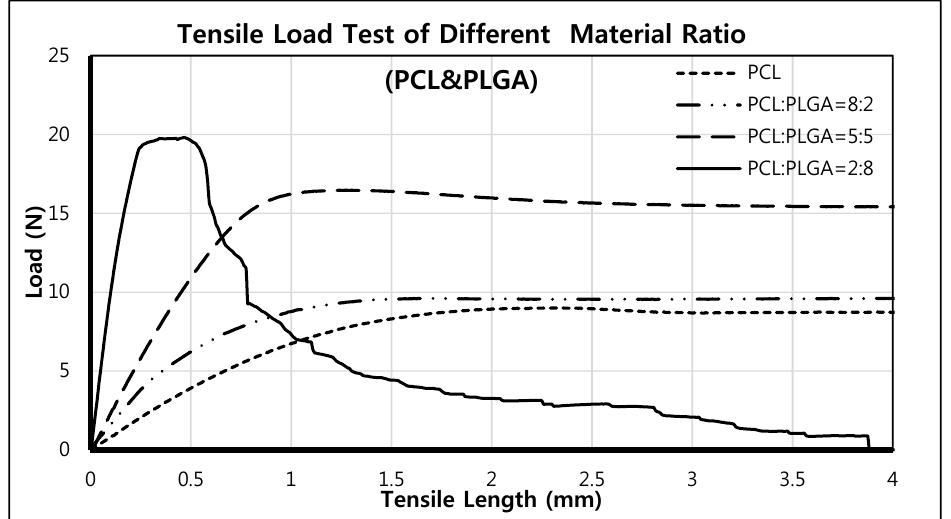
Figure 7. Tensile test results for different material ratios of PCL and PLGA. The elastic modulus and mechanical strength of PCL/PLGA blends gradually increased with PLGA content.